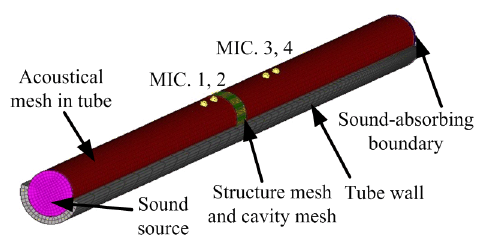
Figure 8. Simulating the measurement of STL using the finite element method (FEM).